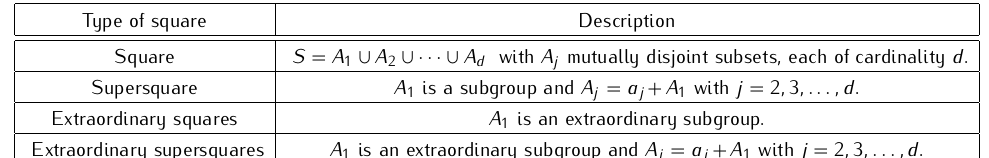
Table 1. Classification of the squares of order d